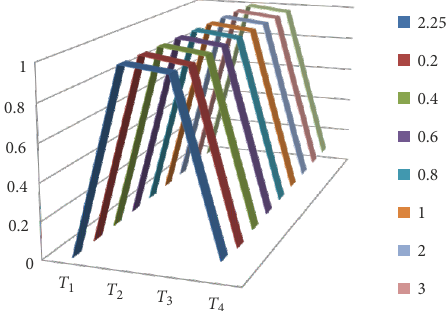
Figure 3. When parameter q changes alone, the results of ℑ ( T k ) in different q